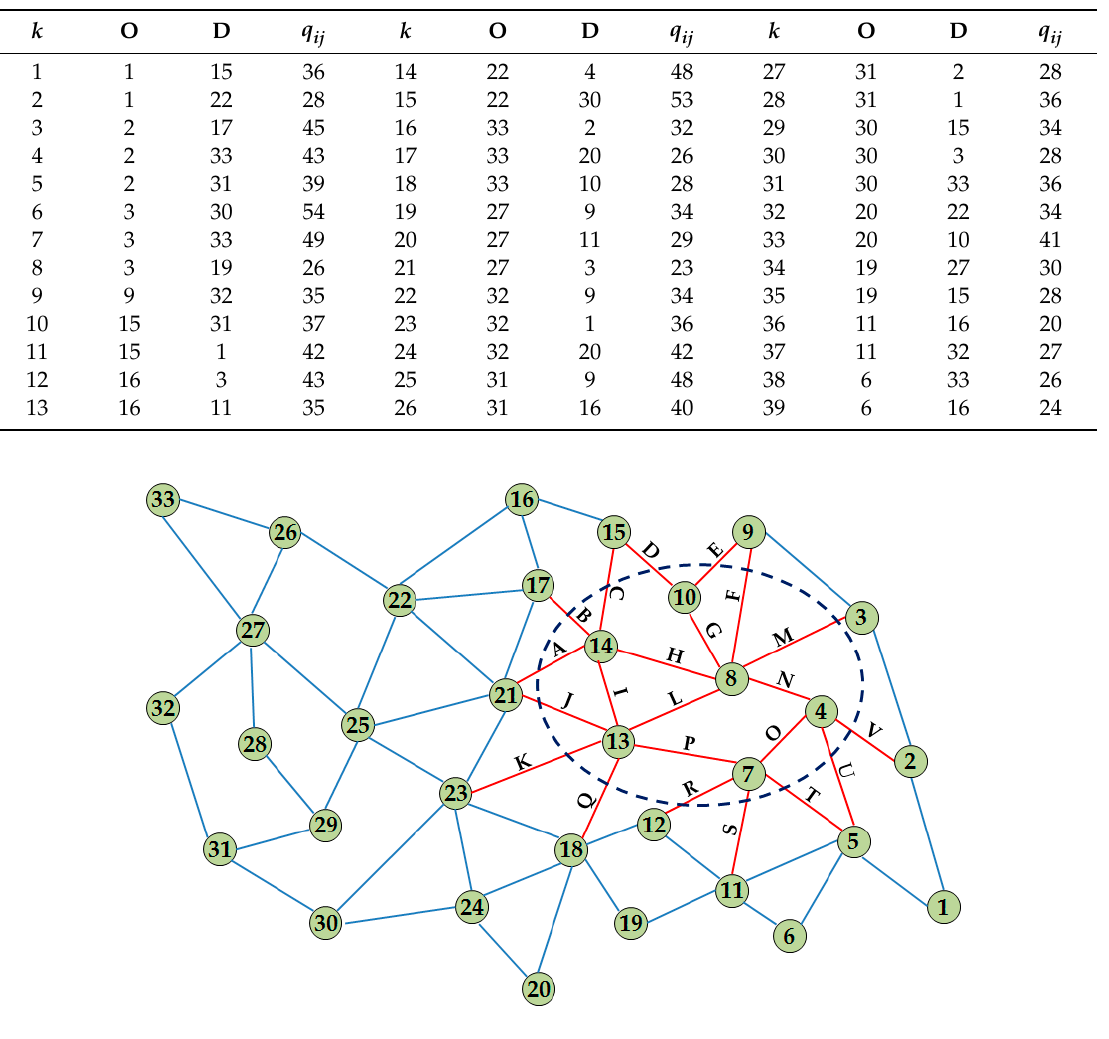
Table 2. OD pairs and their demands.